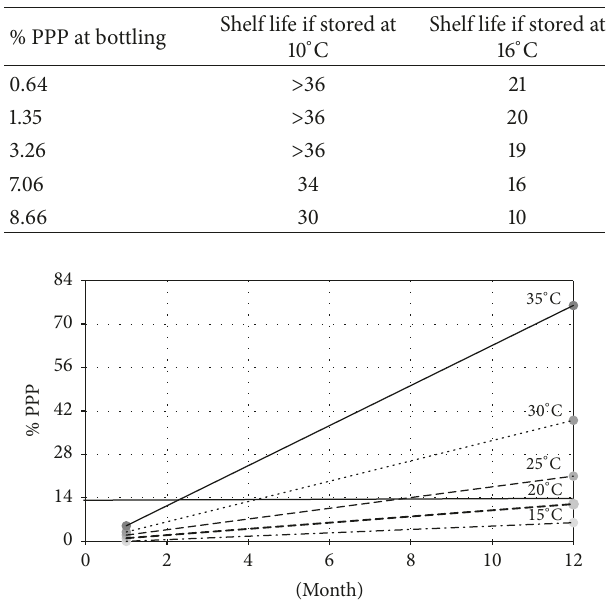
Table 7: Shelf life (in months) for VOO stored at 10 ∘ C and 16 ∘ C before reaching Australian/California limit of 17% summarized from Aparicio-Ruiz et al. (2014).